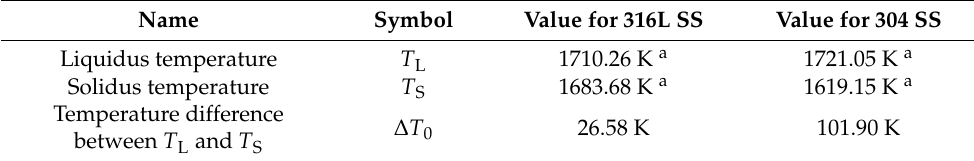
Figure 13. Comparison of ( a ) solidification microstructure (EBSD IPF map) of melt region in 316L SS formed by scanning electron beam and ( b ) a corresponding snapshot of CtFD simulation colored by fluid velocity.